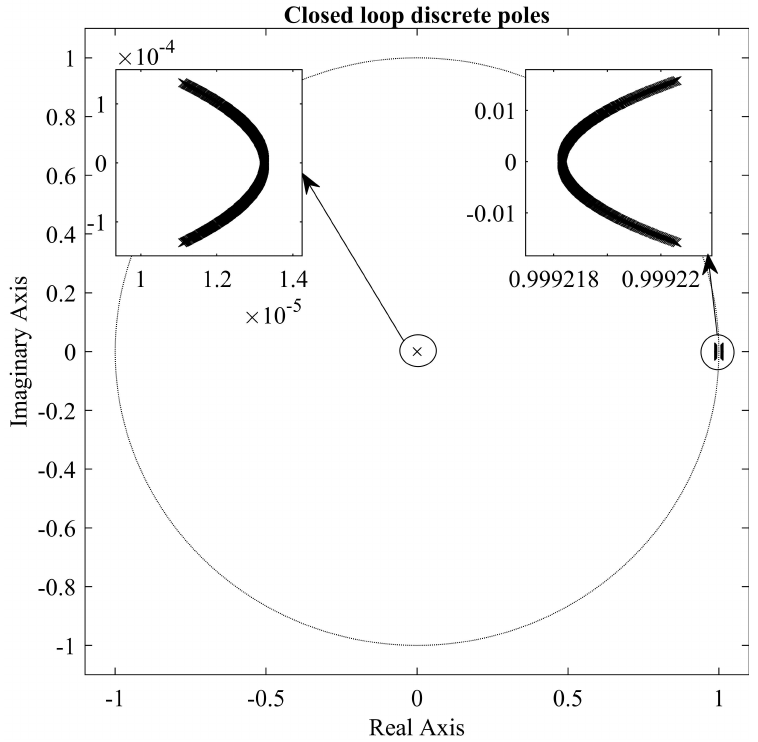
Figure 2. Closed loop discrete system poles for range of rotor speed